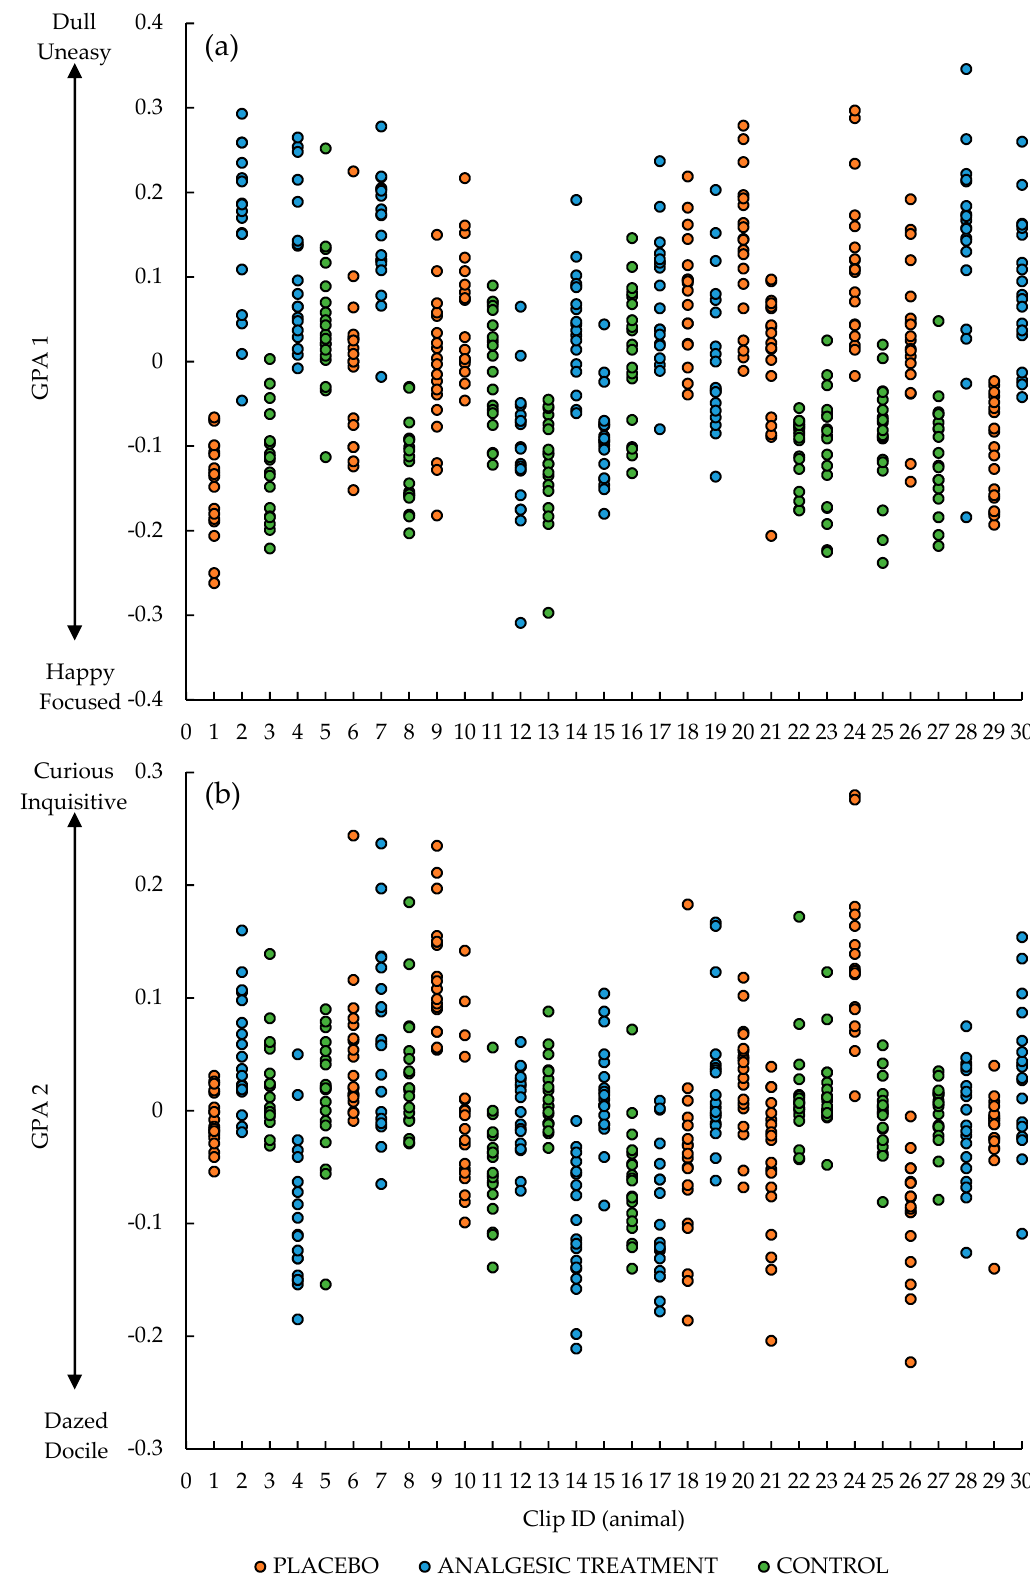
Figure 2. Individual observer General Procrustes Analysis (GPA) scores given to each of the 30 clips (animals) on GPA ( a ) dimension 1 and ( b ) dimension 2.